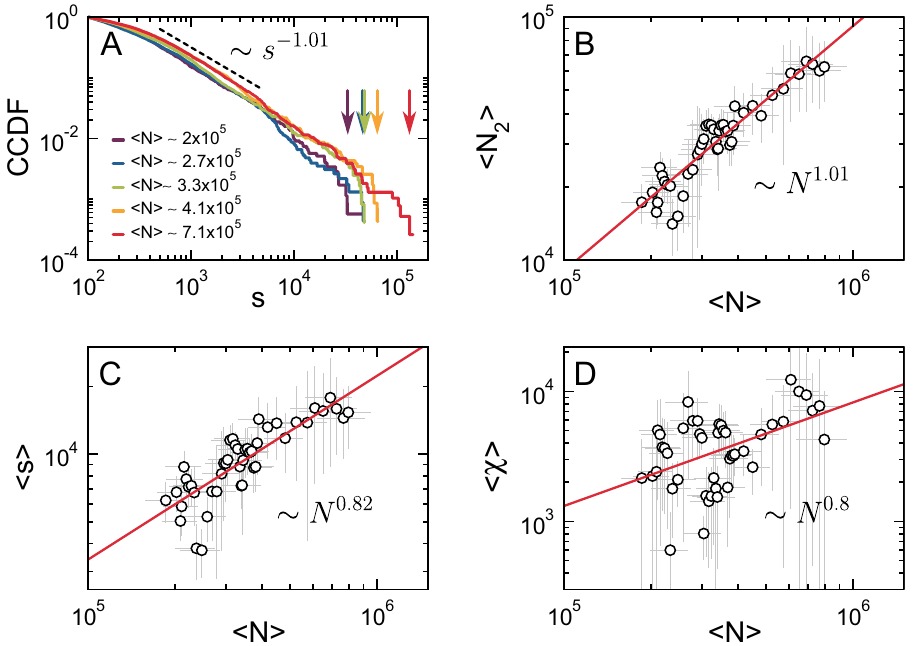
Figure 7. Finite-size scaling analysis of mitochondrial networks from MEFs. ( A ) The CCDF of the cluster mass distribution for different values of the average total mass of the network (cid:31) N (cid:30) , where the dashed line corresponds to a power-law fit of the central part of the distribution with exponent − 1.01 ± 0.01 . Arrows indicate how the large-size cutoff increases as a function of (cid:31) N (cid:30) . ( B ) Log-log plot of (cid:31) N 2 (cid:30) as a function of (cid:31) N (cid:30) , where the solid red line is a power-law fitting with exponent 1.01 ± 0.06 . ( C ) Log-log plot of (cid:31) s (cid:30) as a function of (cid:31) N (cid:30) , where the solid red line is a power-law fitting with exponent 0.82 ± 0.08 . ( D ) Log-log plot of (cid:31) χ (cid:30) (Eq. 10) as a function of (cid:31) N (cid:30) , where the solid red line is a power-law fitting with exponent 0.8 ± 0.23 . (cid:31) N (cid:30) corresponds to the average total mitochondrial mass estimated from images, used here as a proxy for network size. Symbols correspond to mean values and error bars to standard deviations from different intensity thresholds (see